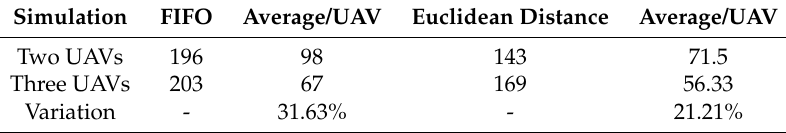
Table 2. Displacement number—Scenario